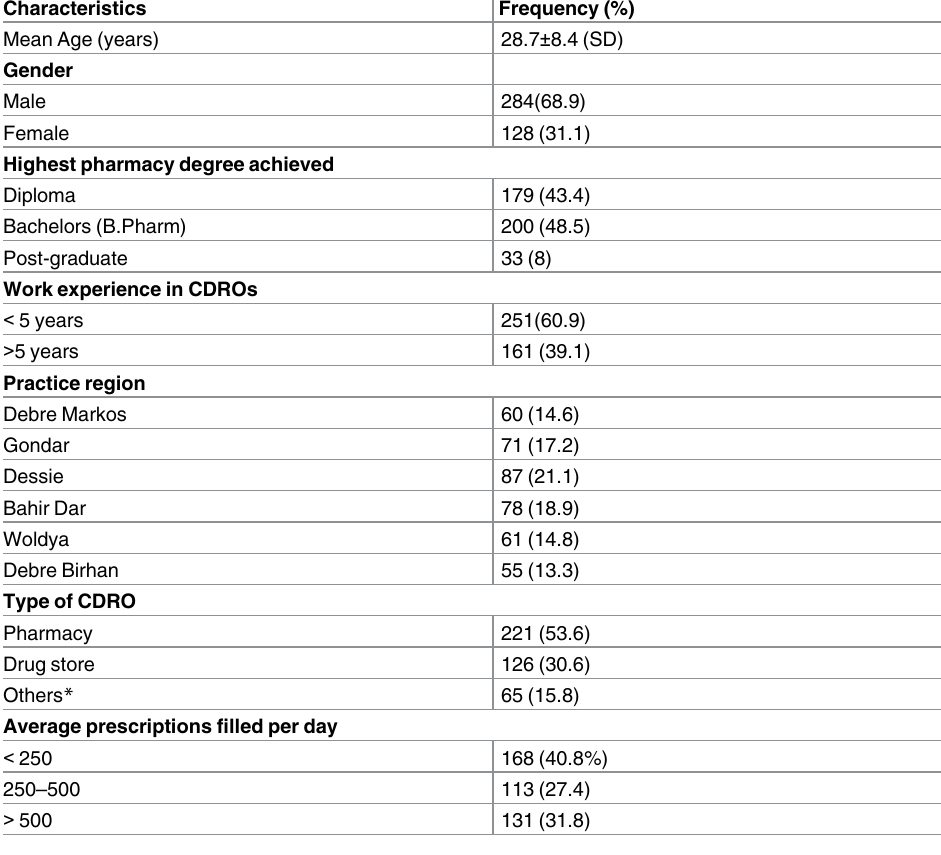
Table 1. Characteristics of community pharmacyprofessionals and CDROs, Amhara, Ethiopia, N = 412.